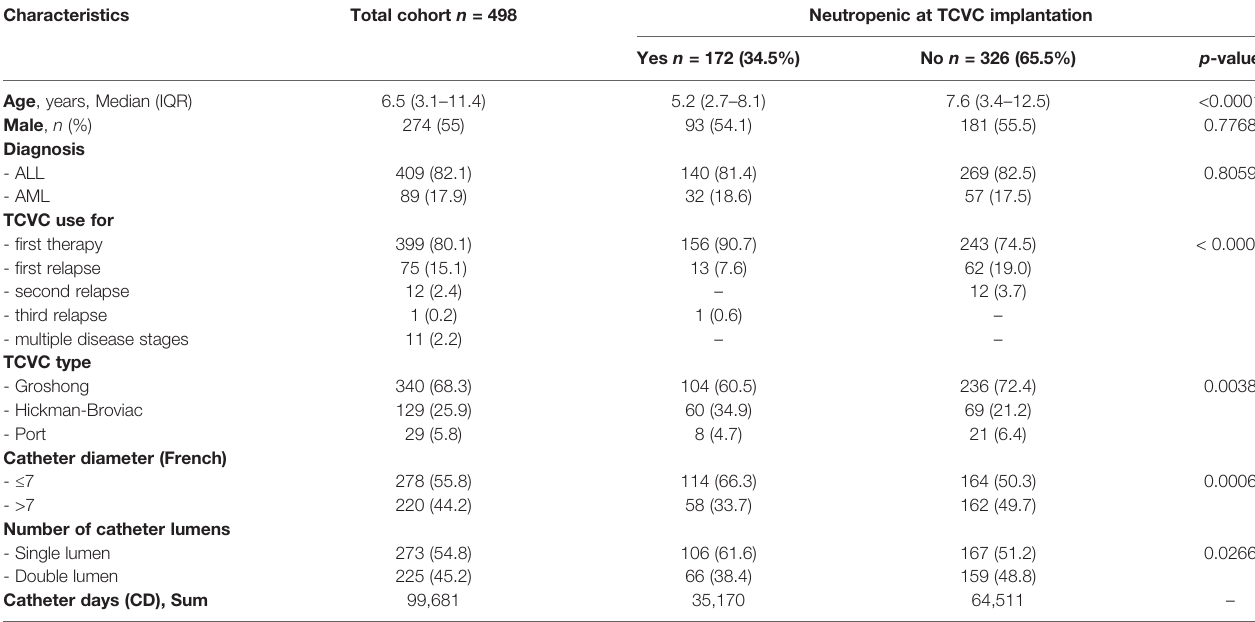
TABLE 1 | Clinical and device characteristics of study